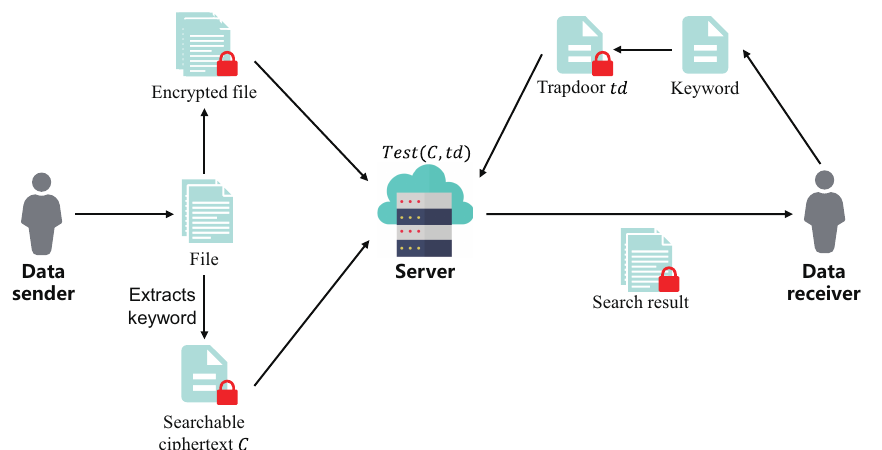
Figure 1. The general framework of PEKS